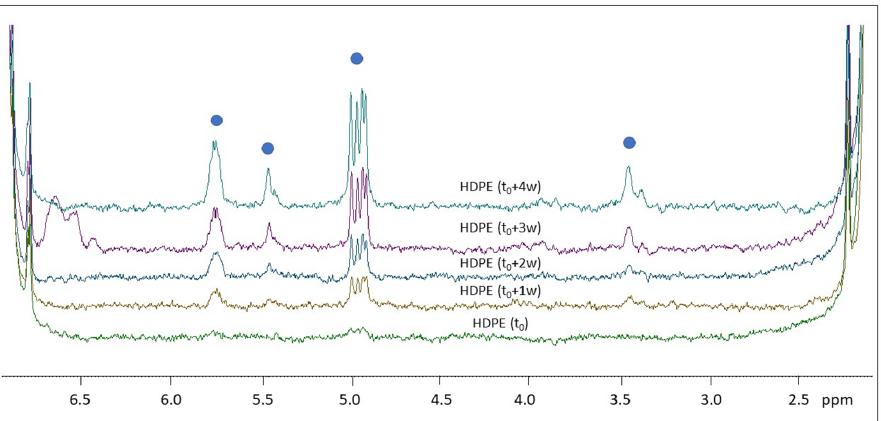
Figure 6. Stackplot of the 1 H NMR spectra of the HDPE microplastics at different times of irradiation (from bottom to top): t 0 , t 0 + 1 w, t 0 + 2 w, t 0 + 3 w, and t 0 + 4 w, enlarged at the spectral baseline in the region between 2.0 and 7.0 ppm. Spectra were normalized with respect to the aliphatic signal centered at 1.3 ppm, due to the CH 2 moiety of the HDPE chain. Blue circles indicate the most significant signals appearing as a result of degradation, as discussed in Section 3.